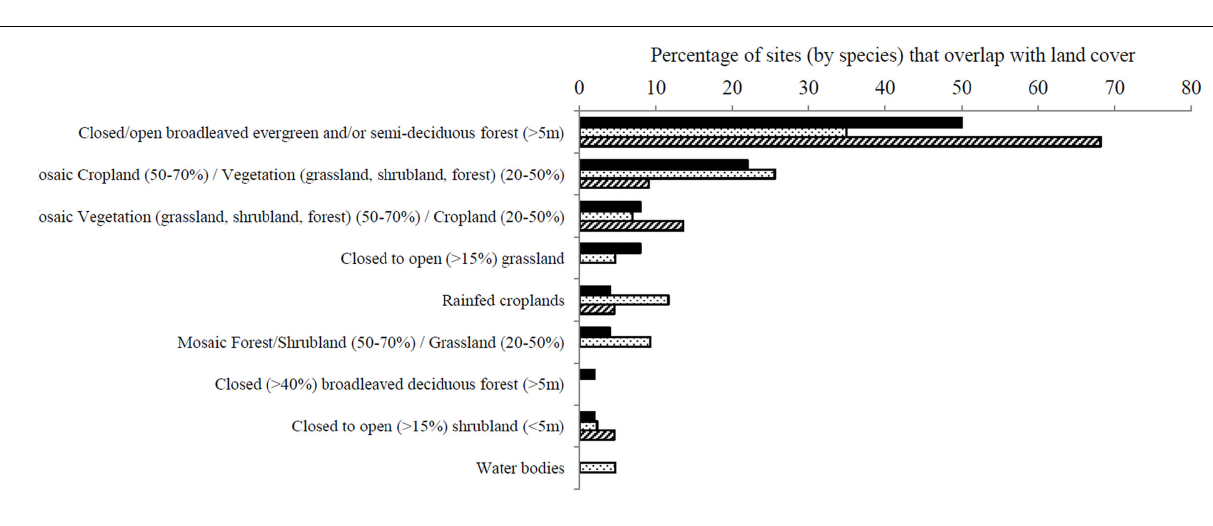
FIGURE 4 | Bi-plot results of principal components analysis of rivers/roads and habitat characteristics for (A)Axes 1 and 2 and (B)Axes 1 and 3. Output from CANOCO (2002).